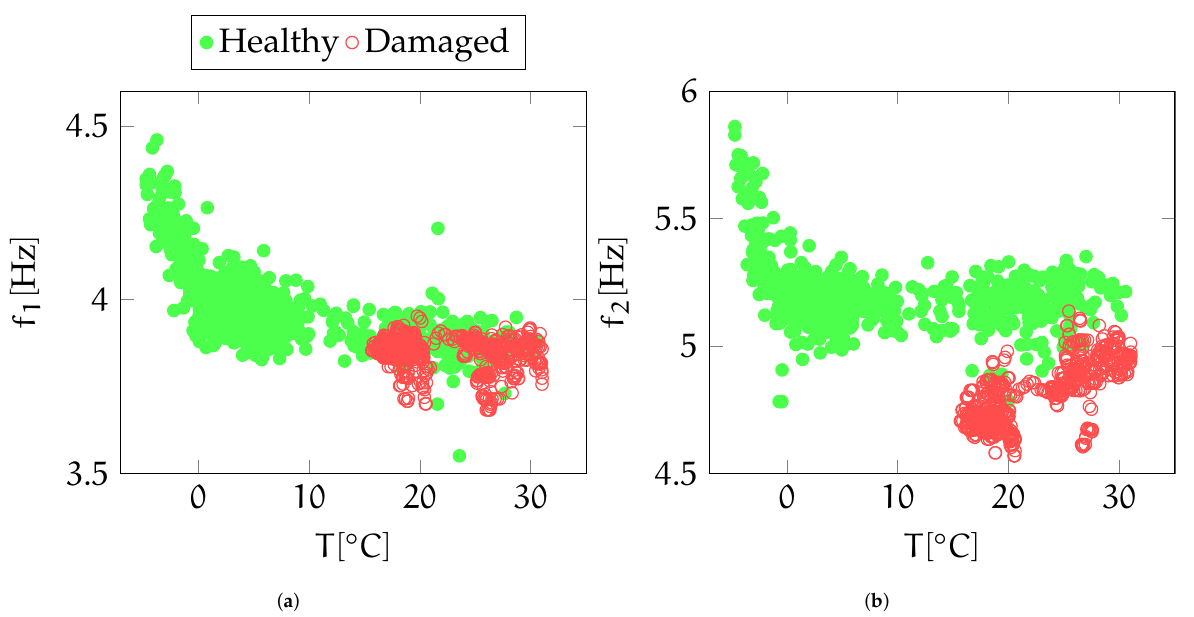
Figure 6. First ( a ) and second ( b ) frequency component vs temperature. Red points concentrating on high temperature values (from 20 °C to 30 °C) are related to damaged structural configurations, while the green ones covering the entire temperature axis refer to the healthy